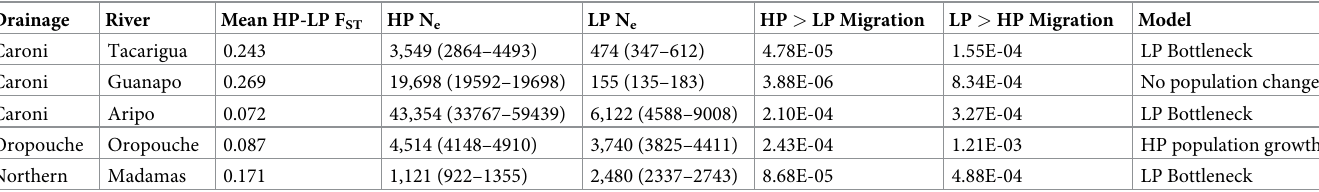
Table 1. Demographic parameters of each river, inferred by fastsimcoal2 . Values in brackets represent confidence intervals of 95% after bootstrapping 100 SFS.